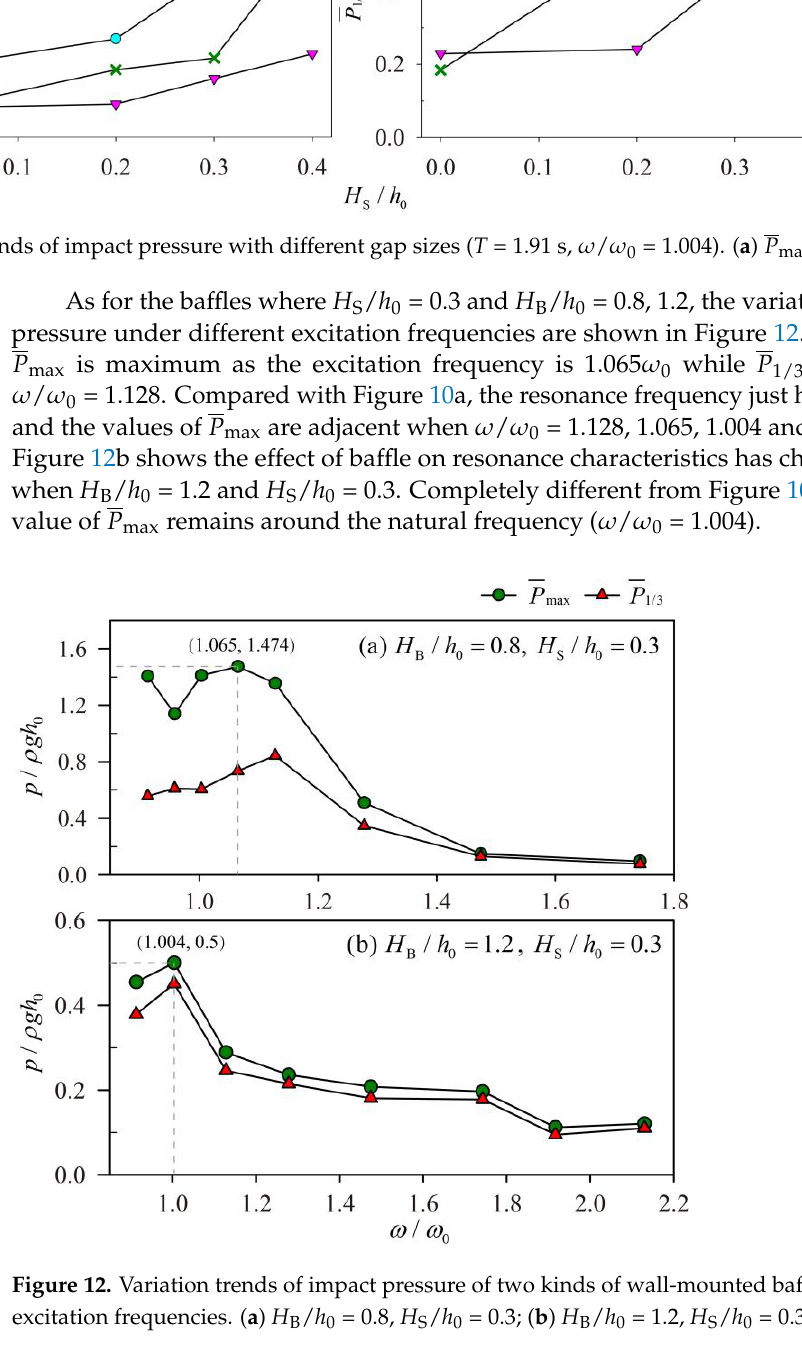
Figure 12. Variation trends of impact pressure of two kinds of wall-mounted baffles under different excitation frequencies. ( a ) H B / h 0 = 0.8, H S / h 0 = 0.3; ( b ) H B / h 0 = 1.2, H S / h 0 =